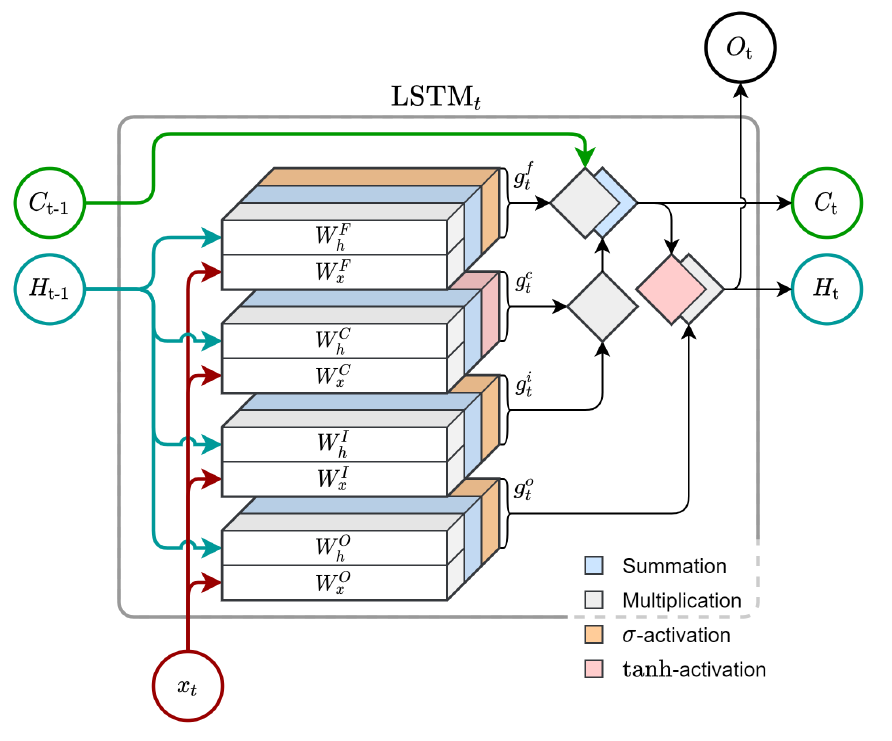
Figure 2. The inner architecture of an LSTM at a time step t . The model takes as its inputs the previous cell state C t − 1 and hidden state H t − 1 with the current item x t of the input sequence. The H t − 1 and x t are then passed to forget ( W F ), cell ( W C ), input ( W I ) and output ( W O ) gates. These